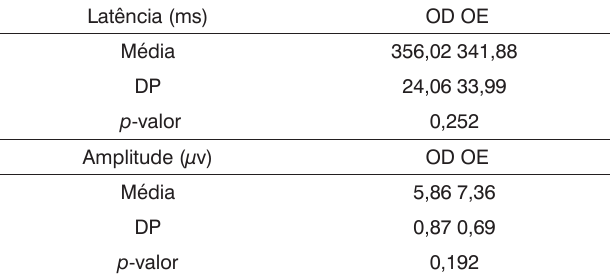
Tabela 3. Média, Desvio Padrão (DP) e p -valores referentes às latências e amplitudes do P300 para estímulo verbal em orelha direita (OD) e orelha esquerda (OE).